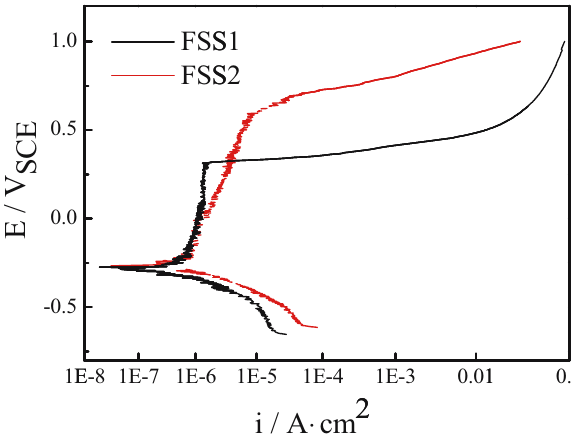
Figure 5: Potentiodynamic polarization curves of experimental steel samples in 10% NaCl at